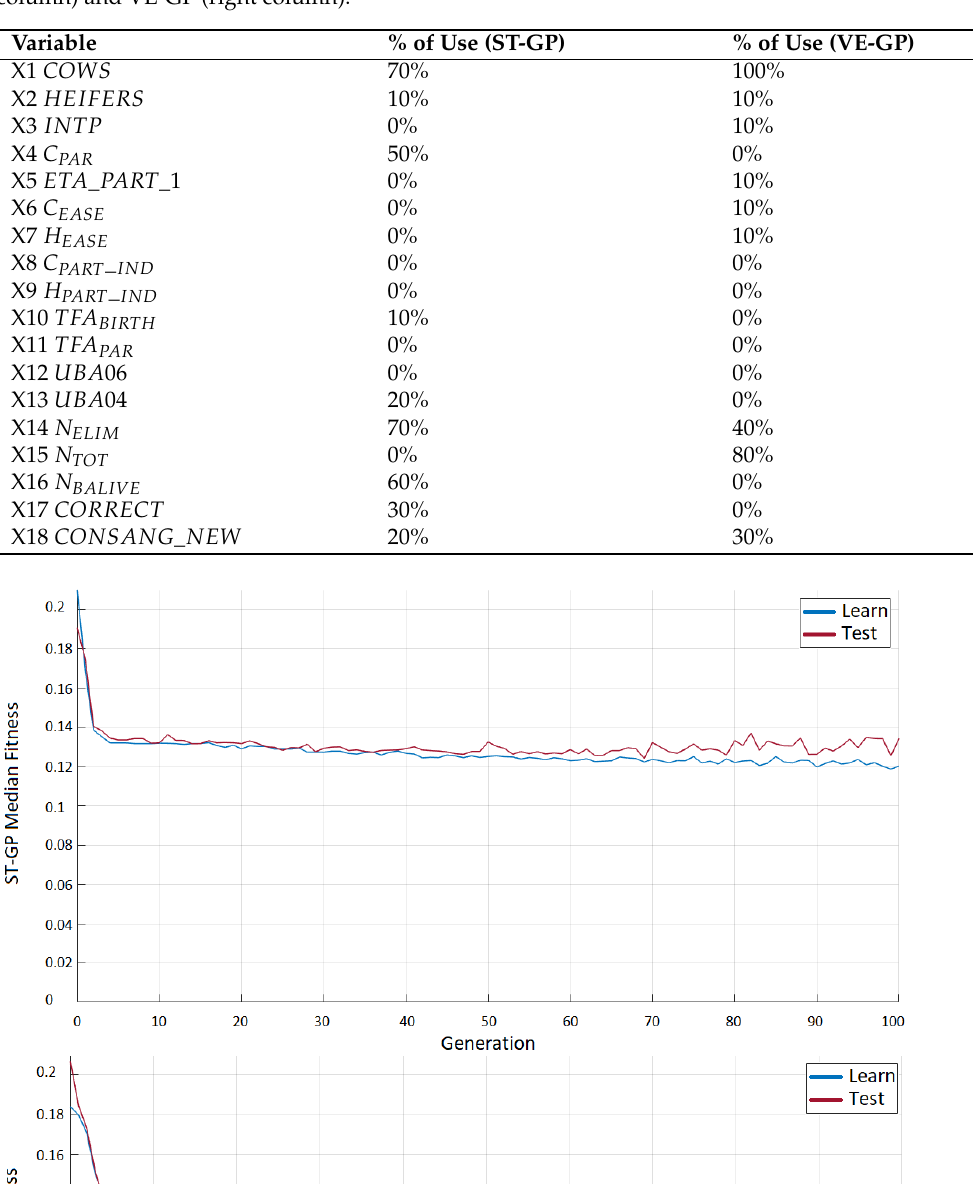
Table 7. Frequency of use of each variable among the best 10 individuals found by ST-GP (left column) and VE-GP (right column).